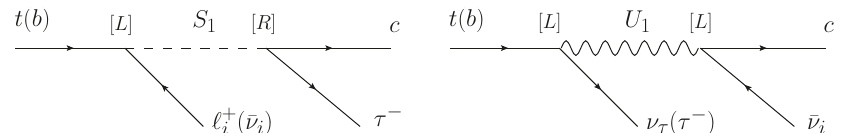
Figure 1 . Tree-level top FCNC decays considered in this work, induced by SU(2) singlet scalar LQ S 1 and vector LQ U 1 .